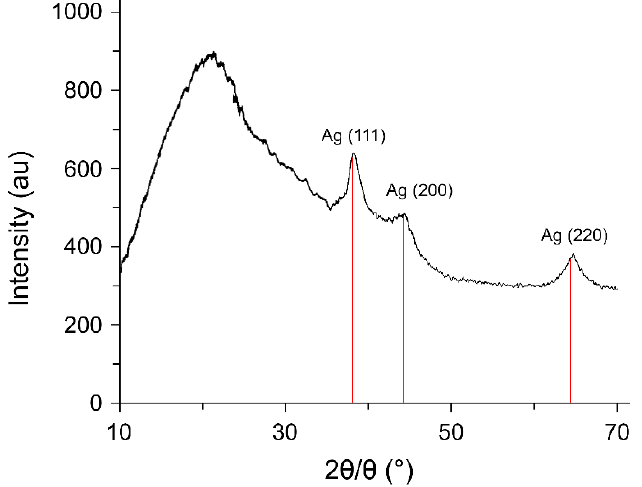
Figure 4. X-ray diffraction pattern for nanocomposite with AgNPs stabilized by poly(VT-co-Na-VSA).